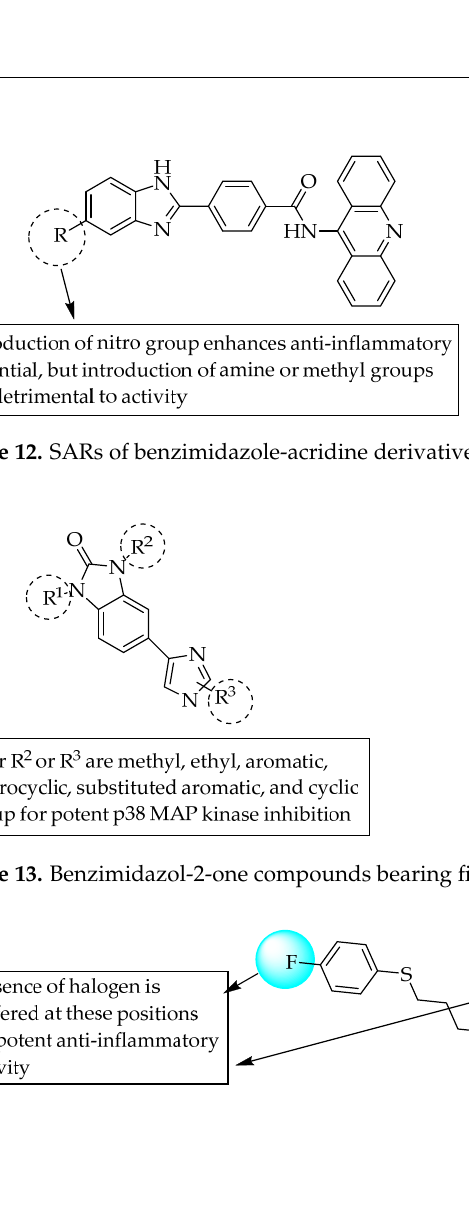
Figure 14. SARs of 1,2,5-trisubstituted benzimidazole as CCR3 receptor inhibitor.